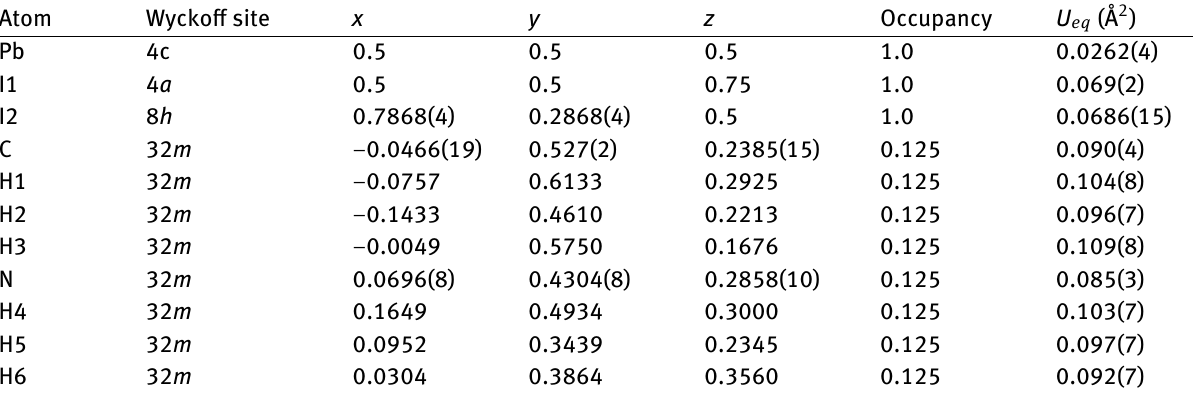
Table 5: Structural parameters of tetragonal CH 3 NH 3 PbI 3 . For space group I 4/ mcm (140), a = 8.8796(6), c = 12.6266(18) Å at 295 K. U eq